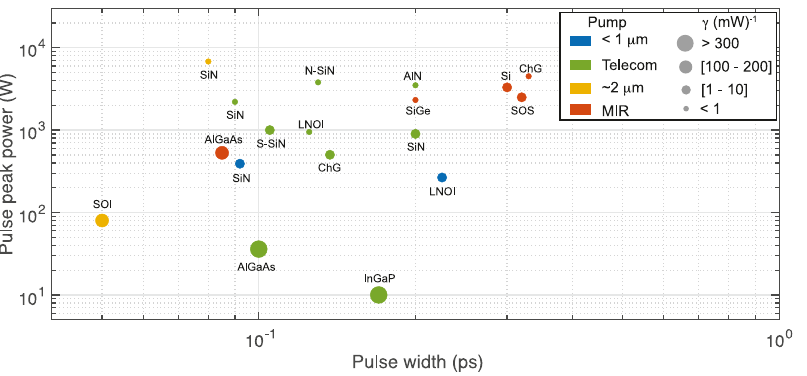
Figure 20: Peak power and pulse width for various demonstrations of octave spanning SC in chip-based platforms. The colors indicate the wavelength of the pump while the size of the marker indicates the magnitude of the nonlinear coefficient 𝛾 of the used